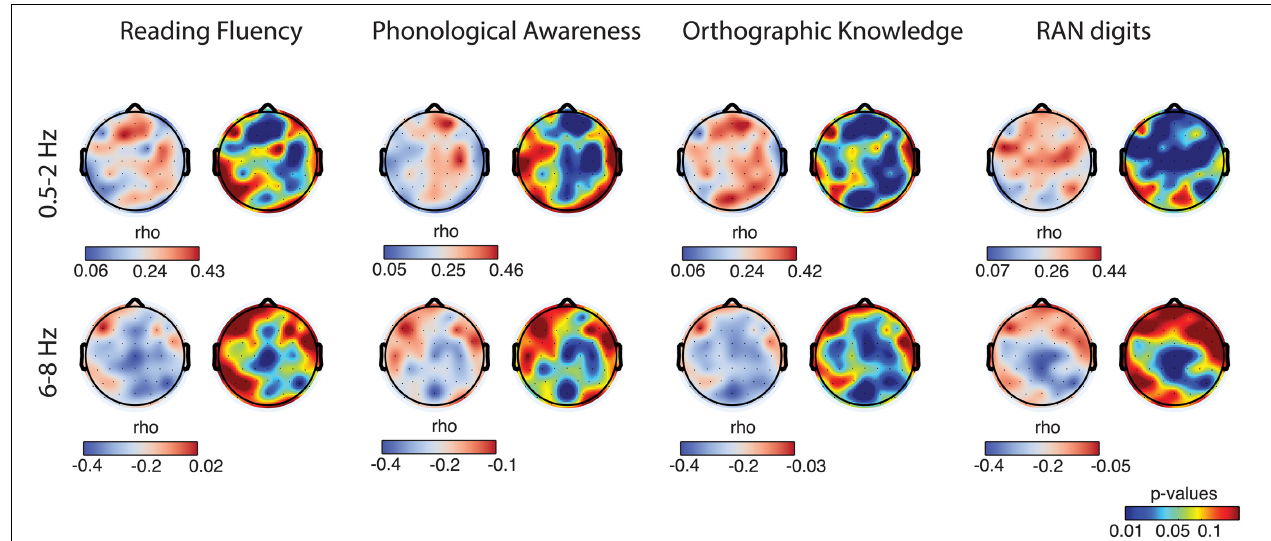
FIGURE 5 | Correlation topographies. For each behavioral task, correlations with delta-1 ( first row ) and alpha-1 ( second row ) relative amplitude of all the subjects are shown in the form of correlation coefficient (r) topographies (cool-warm color map) and p- value topographies (jet color